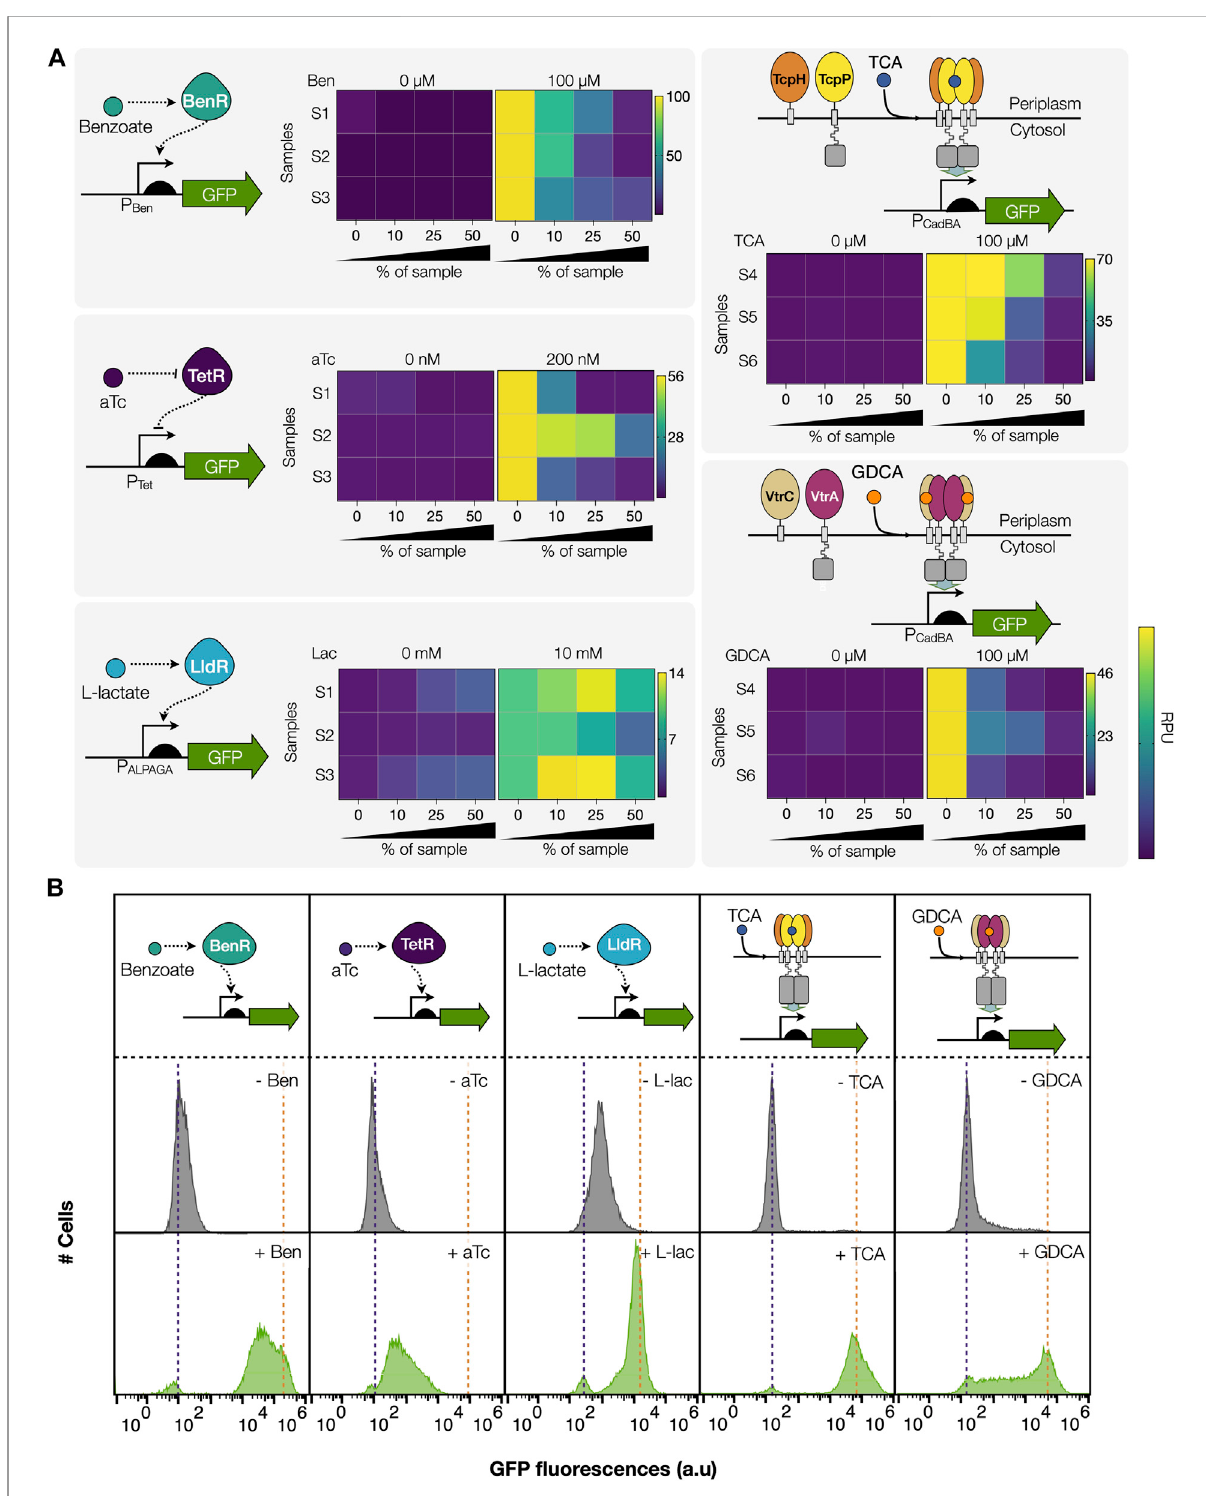
FIGURE 2 Performance of different bacterial biosensors in human feces. (A) Matrix effects of human feces samples on the performance of fi ve different biosensors. Samples from different patients were used, S1-S6 represent the labels for the different patient samples. Biosensors at the top are based on cytosolic transcription factor systems: the BenR activator and the pBEN promoter; the TetR repressor and the pTET promoter and the LldR regulator and the pALPAGA promoter, induced with 100 µM benzoate, 200 nM aTc and 10 mM L -lactate, respectively. Sensors at the bottom